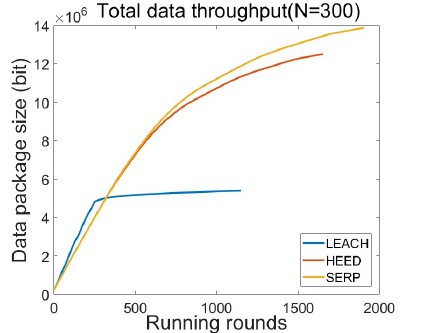
Figure 10. Total data throughput when the number of nodes N =